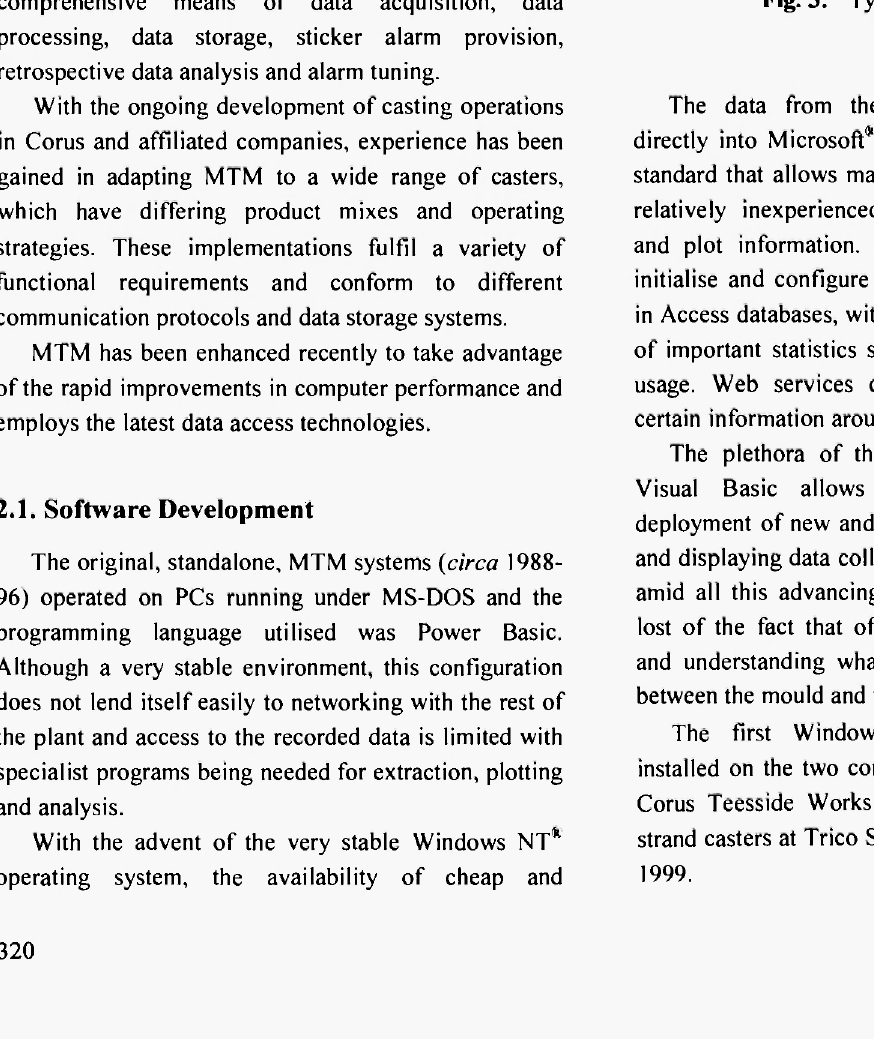
Fig. 3: Typical MTM